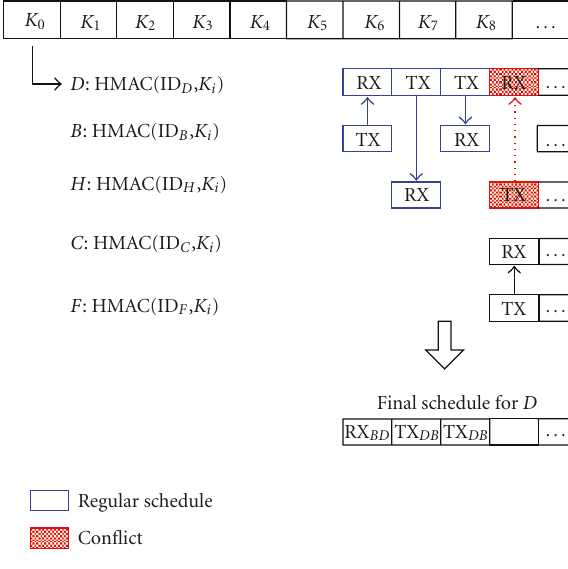
Figure 9: Implicit conflict